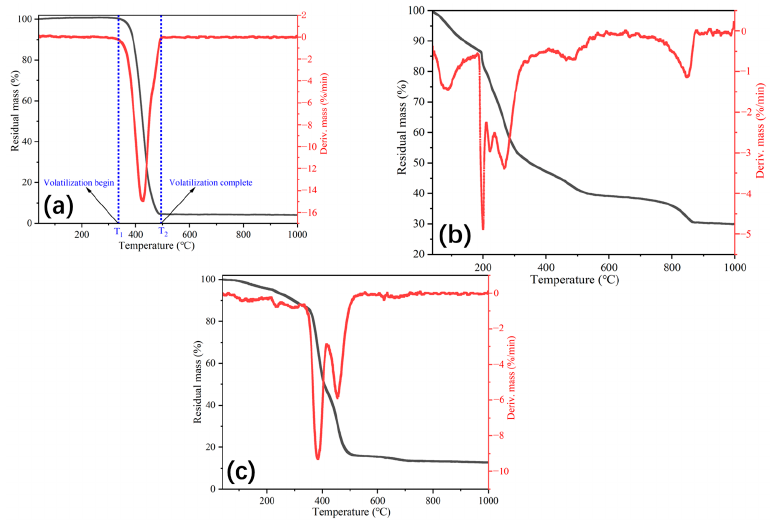
Figure 7. The mass loss of different materials. ( a ) Healing agent, ( b ) blank Ca alginate capsule without the healing agent, and ( c ) Ca alginate capsule containing the healing agent.